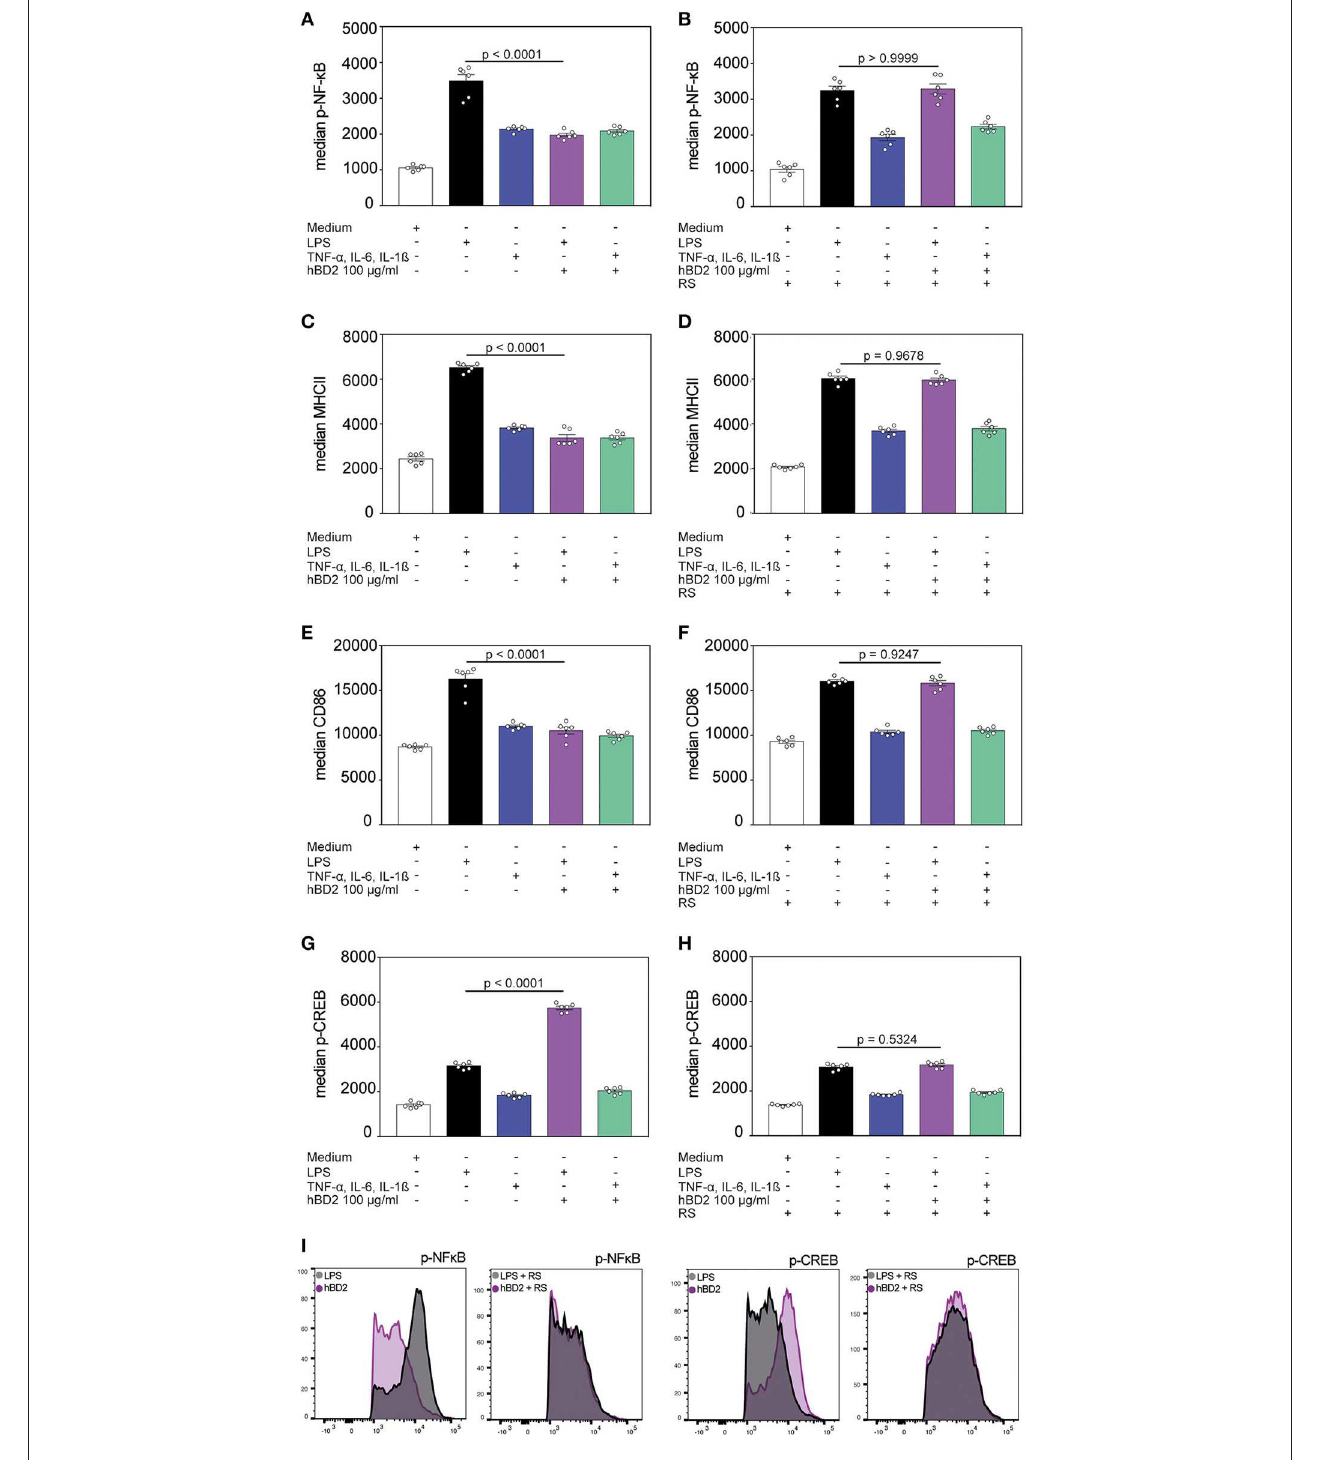
FIGURE 4 | hBD2 modulates NF- κ B and CREB phosphorylation. BM-DC’s were incubated for 60min with LPS (10 µ g/ml) or a cytokine cocktail containing TNF- α (0.2mg/ml), IL-6 (0.2mg/ml), and IL-1 β (0.2mg/ml) alone or in combination with hBD2 (100 µ g/ml). BM-DCs were additionally pretreated with pertussis toxin or the CCR2 inhibitor RS prior to stimulation. The cells were stained with CD11c, MHCII, and CD86 antibodies followed by intracellular staining against p-NF- κ B or p-CREB and analysis by flow cytometry. Statistical analysis of (A,B) p-NF- κ B, (C,D) MHCII, (E,F) CD86, and (G,H) p-CREB staining. (I) Shows histograms of FACS analysis. Results are presented as mean ± SEM, n = 6. Statistical test used is one-way ANOVA with Bonferroni post-test.